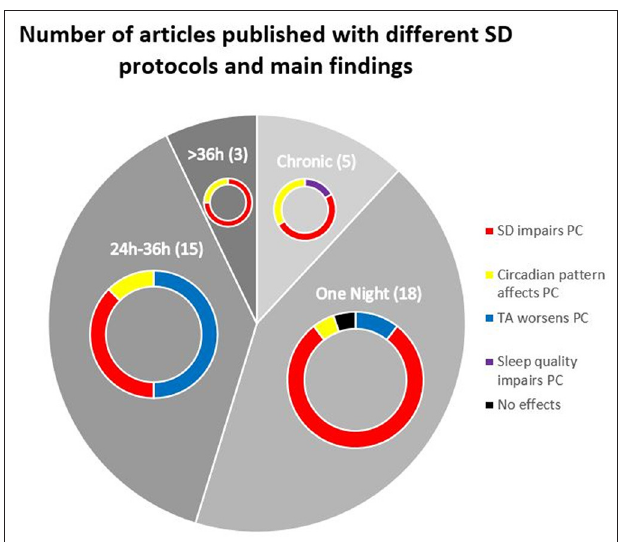
FIGURE 2 | Pie chart indicating the number of papers that used different sleep deprivation protocols to assess postural control along with their main results.